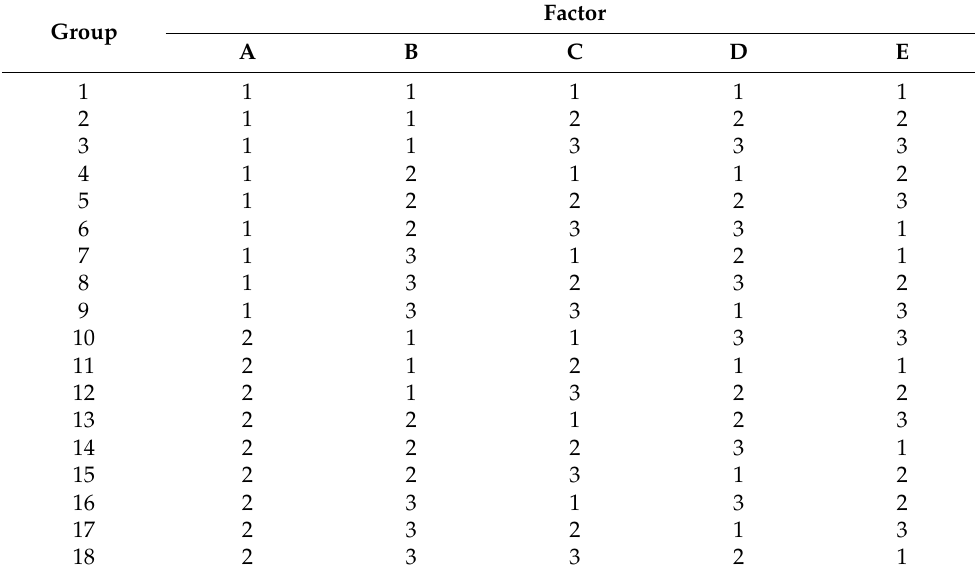
Table 1. The standard Taguchi’s L 18 (2 1 × 3 4 ) orthogonal array, where the numbers in each column, except the first column, indicate the specific factor (A–E) level or practical arrangement.